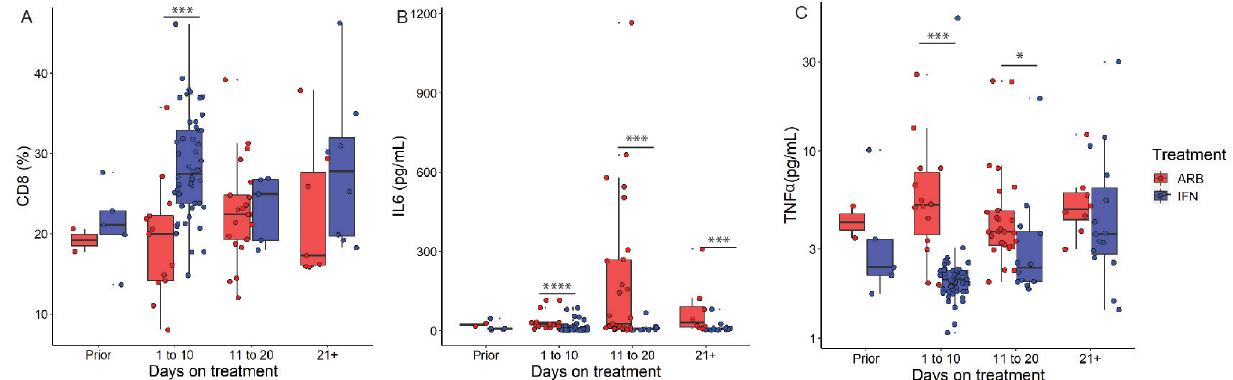
Figure 5. IFN- α 2b treatment regulates the levels of clinical and immune biomarkers associated with lung CT image abnormalities. COVID-19 cases were treated with either ARB alone (ARB, n = 24) or IFN- α 2b with or without ARB (IFN, n = 53). % CD8+ T cells ( A ) and levels of IL-6 ( B ) and TNF- α ( C ) are depicted across the time course of treatment with either ARB or IFN; p values were calculated using the non-parametric Mann–Whitney U test with Holm’s correction for multiple comparisons. * p < 0.05, *** p < 0.001, **** p <